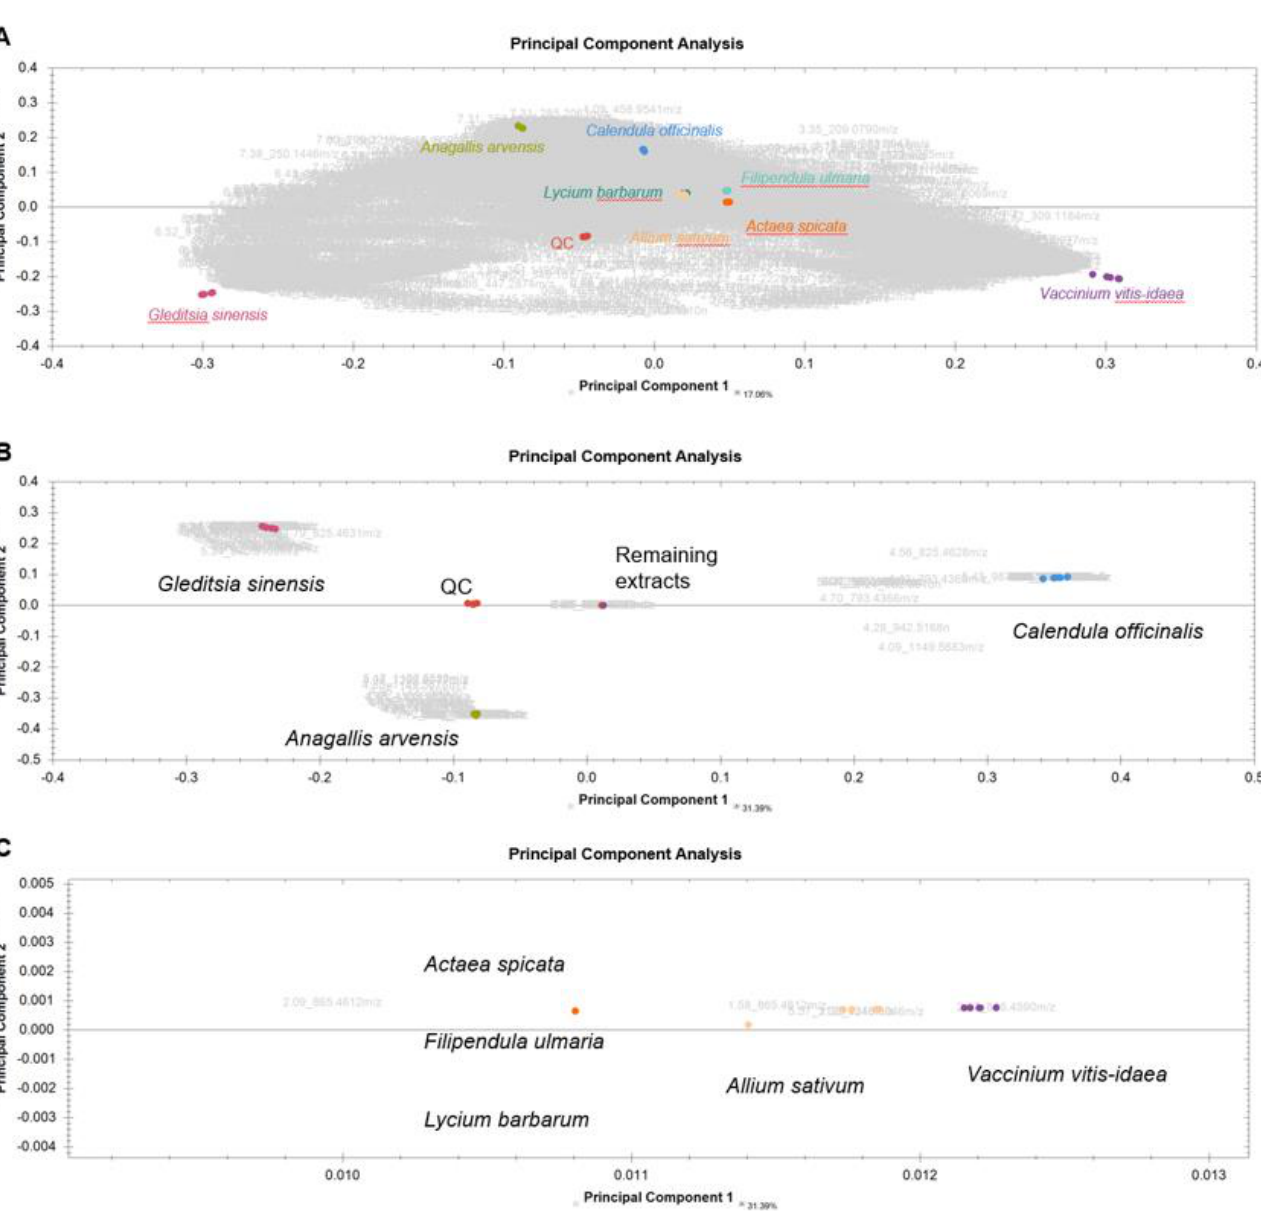
Figure A7. Principal components analysis (PCA) biplot showing scores (colored dots) and loadings (compound IDs in grey with retention time and m / z values) of UPLC-ESI-IMS-TOF MS runs of selected plant extracts. Different colors refer to different plant species. The QC scores are depicted in red. ( A ) PCA of all compounds (no filters), ( B ) PCA with only possible identifications and ( C ) zoomed-in area.